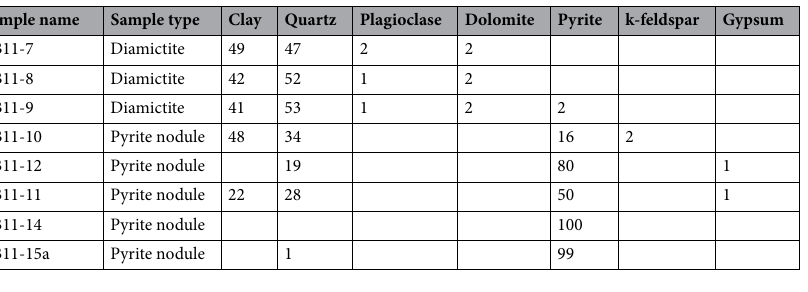
Table 1. Mineral composition and estimated weight percentage (± 10%) in bulk diamictite and pyrite nodule